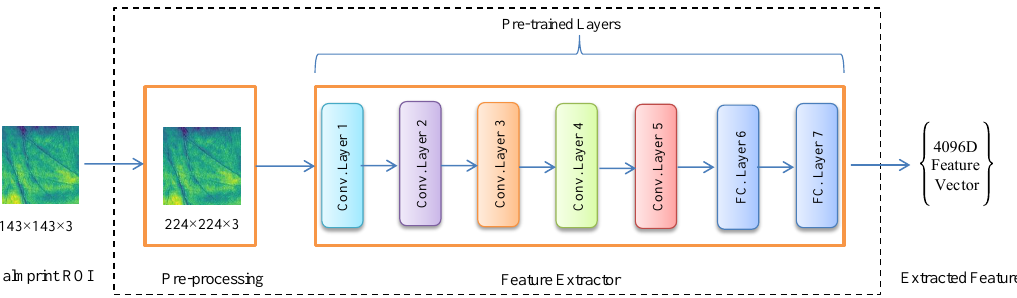
Figure 4. Feature extraction